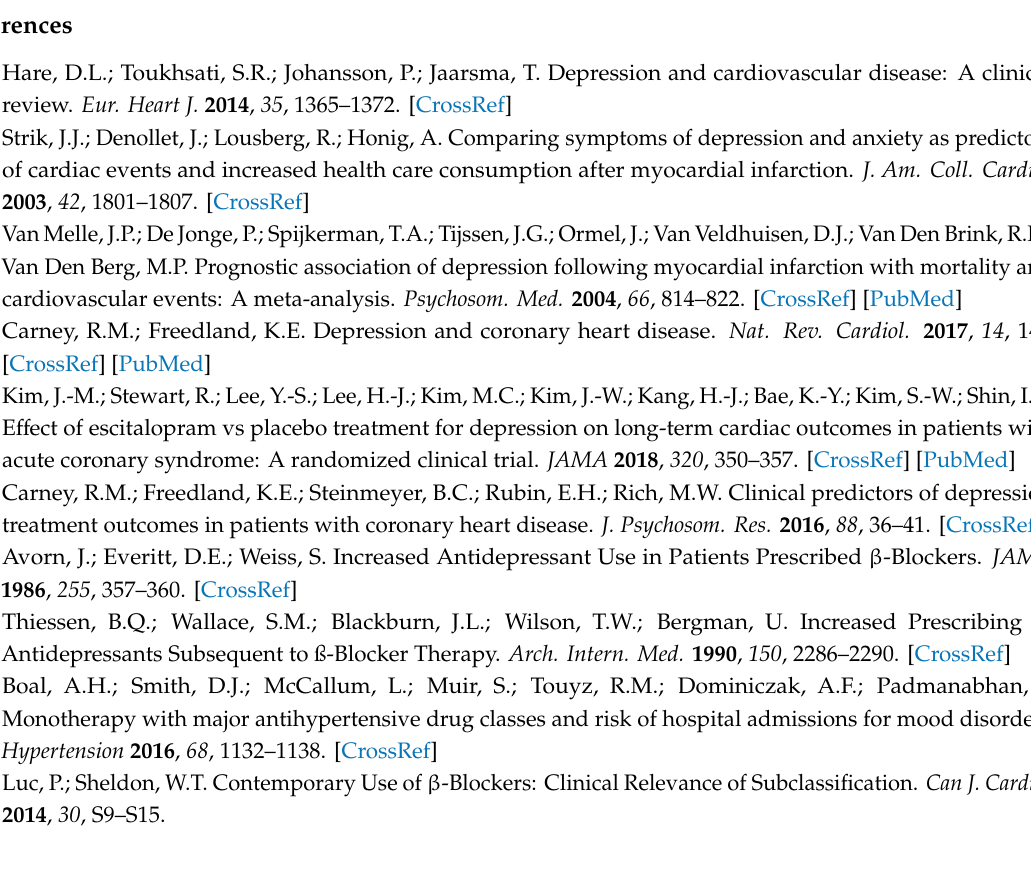
Table S1: Description of the USA databases used in validation, Table S2: The concepts and logics used to define the target cohort and outcome event, Table S3: The settings and results of experimental models, Table S4: Number of patients and outcome incidence by age group, Table S5: Full list of variables selected in the final model, Table S6: The number of beta-blocker prescriptions by its selectivity and lipophilicity, Table S7: Number of patients and outcome incidence by history